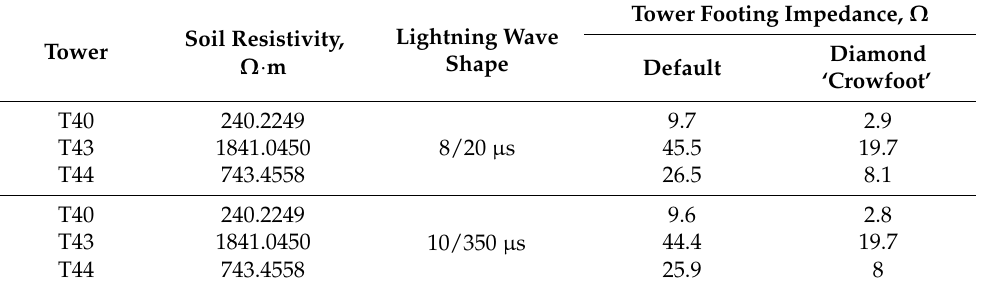
Table 9. Tower footing impedance for lightning waveshape variations before and after improvement. Tower Footing Impedance, Lightning Wave Soil Resistivity, Tower Ω · m Shape